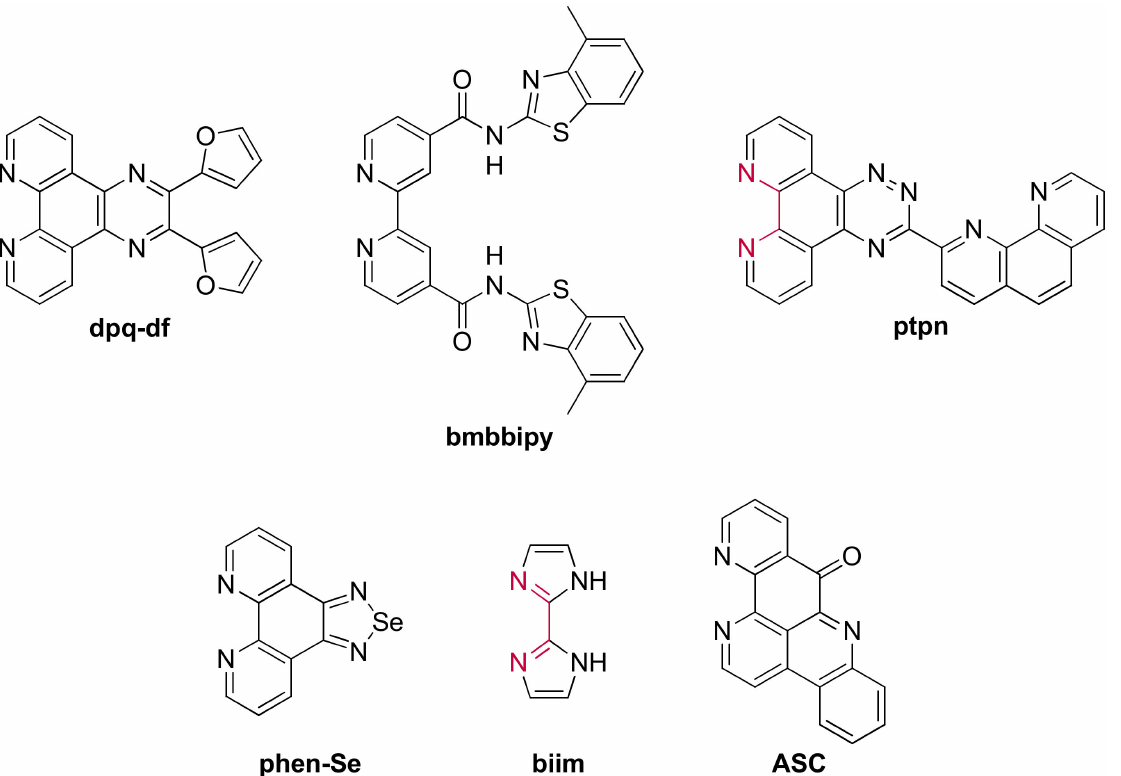
Figure 22. Structure of other types of ligands used to form ruthenium(II) complexes studied in presence of G-quadruplexes.